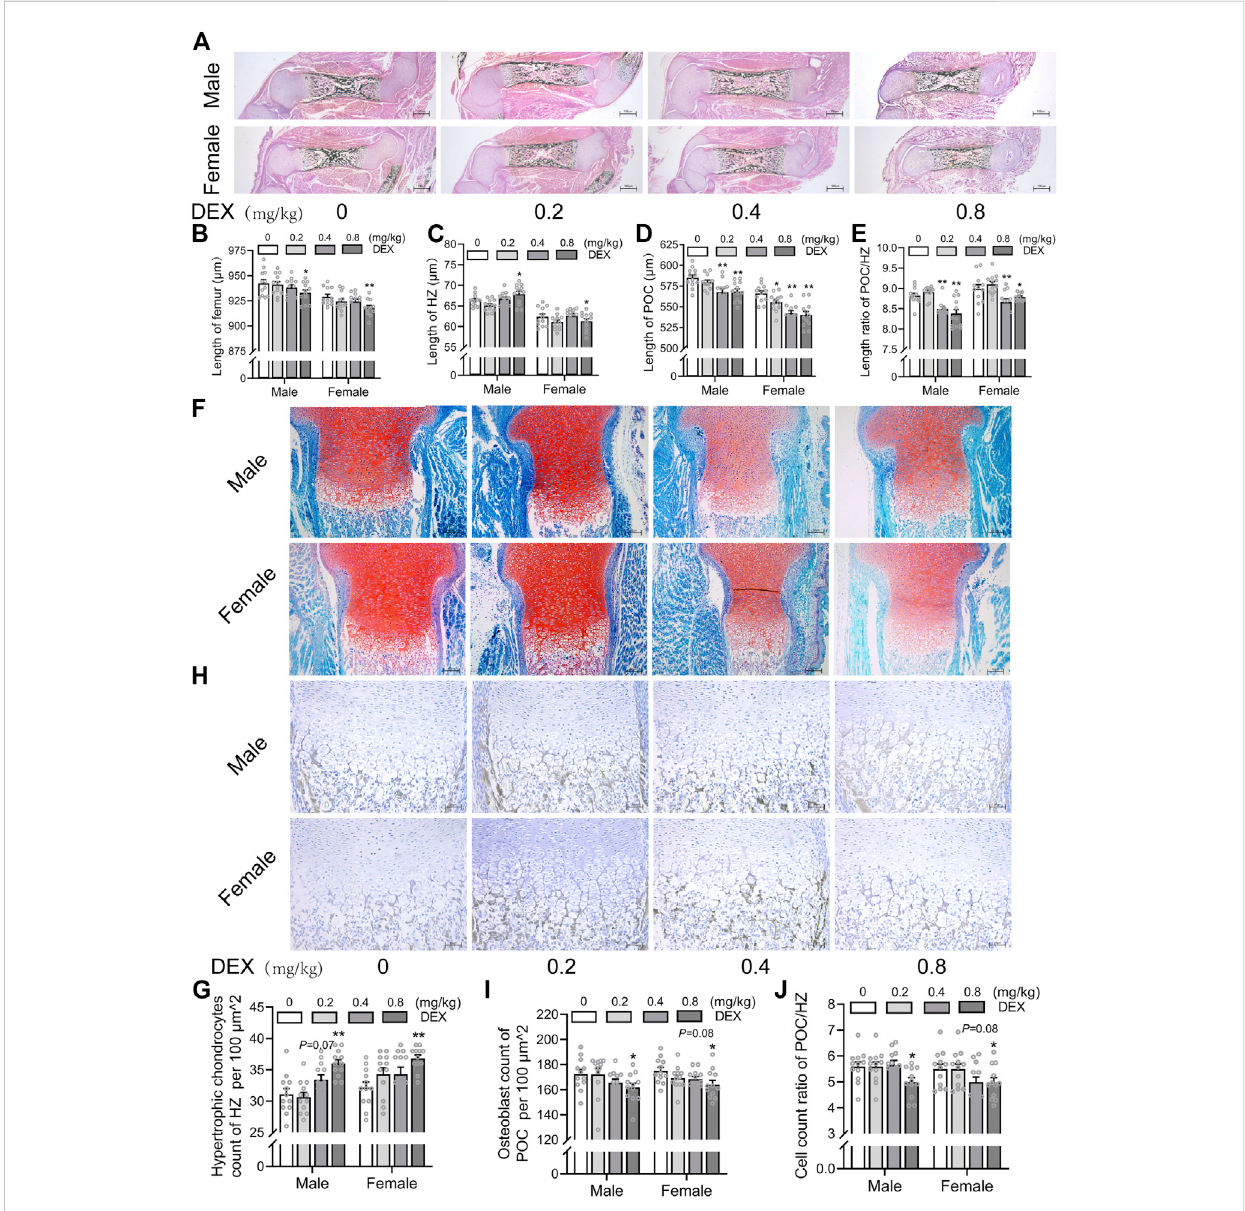
FIGURE 2 Effectsofdifferentdosesofdexamethasoneexposureonbonedevelopmentandchondrocyte-to-osteoblasttrans-differentiationinfetalmice. (A) . Typical images of vonkossa staining in fetal bone tissue; (B) . Quantitative analysis of fetal femur length; (C) . Quantitative analysis of the width of hypertrophy zone (HZ) in growth plate; (D) . Quantitative analysis of the length of the primary ossi fi cation center (POC); (E) . The ratio between the length of the POC and the width of HZ in the growth plate cartilage; (F) . Typical images of fetal bone tissue stained with saffron O and solid green; (G) . Analysisofhypertrophicchondrocytesnumberingrowthplatecartilage; (H) .Typicalimagesofalkalinephosphatase(ALP)staininginfetalbonetissue; (I) . Analysis ofosteoblastsnumberinthePOC; (J) .The relativeratioofthenumber ofosteoblasts inPOC tothenumber ofhypertrophiccells ingrowth plate cartilage. * p < 0.05 , **p < 0.01 , 0 v.s. 0.2 or 0.4 or 0.8